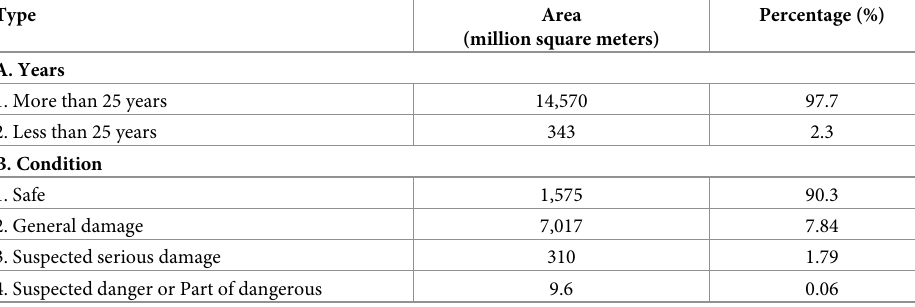
Table 1. Old housing security screening in Shanghai in